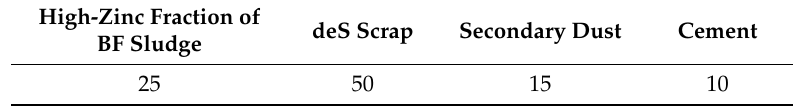
Table 4. Recipe of the briquettes and pellets used in the laboratory-scale smelting reduction experiments (wt.%). High-Zinc Fraction